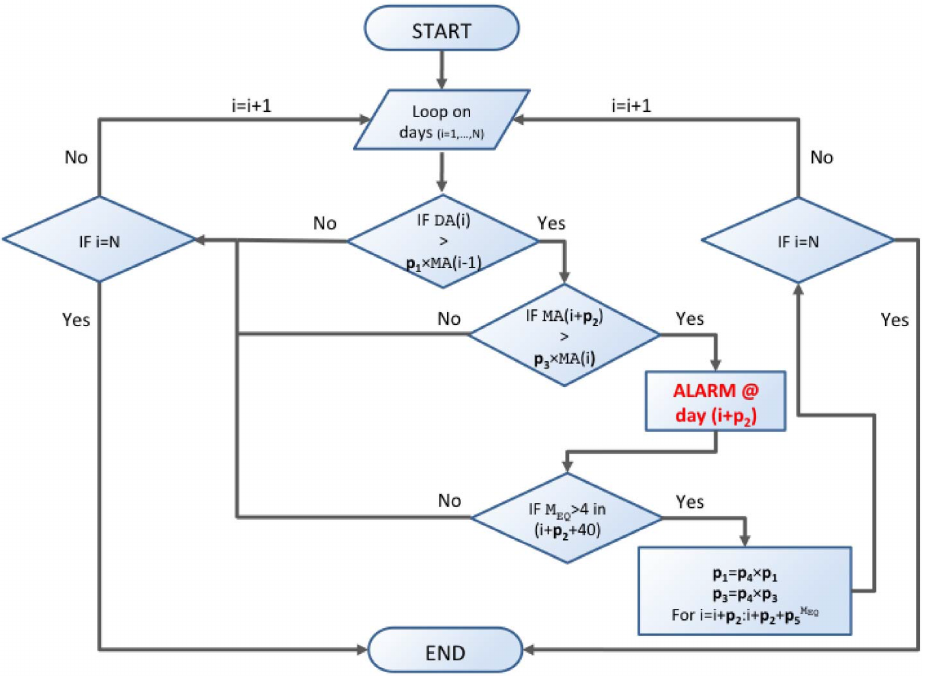
Figure 10. Flow chart representing the detection algorithm. ( p 1 , p 2 , p 3 , p 4 , p 5 ) are the free five parameters described in the text. DA and MA are the daily and the 2-week moving average of radon time series, respectively. M EQ is the magnitude ( > 4) of the earthquake occurring (if any), during 40 days after the alarm.